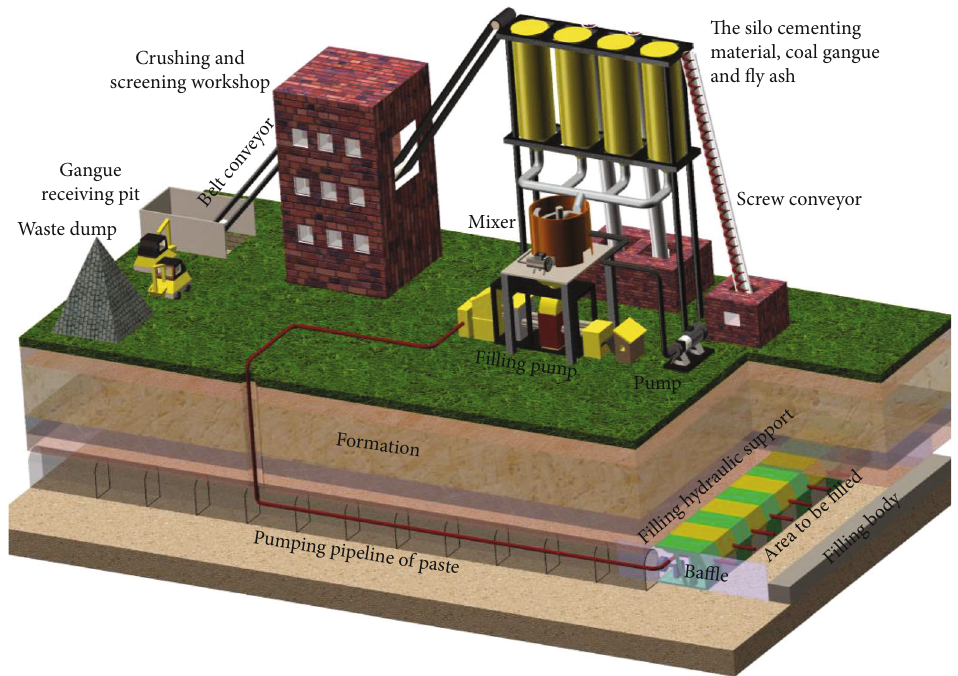
Figure 1: Coal mine paste fi lling